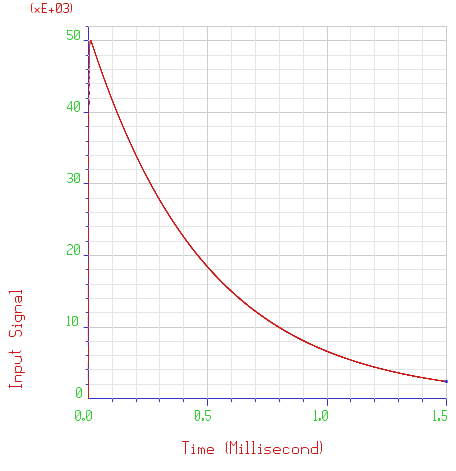
Figure 4. Lightning current waveform (50 kA, 10/350 μs).